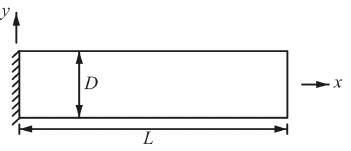
Figure 12. Free vibration analysis of a 2D cantilever beam. As shown in Figure 13a,b, the beam is meshed with two elements for QUAD4 element, FE-RPIM QUAD4 element and QUAD8 element. For TRIG3 element, the problem domain is meshed with four elements, as shown in Figure 13c. A distortion parameter, 2 d / D , is adopted to control mesh distortion.